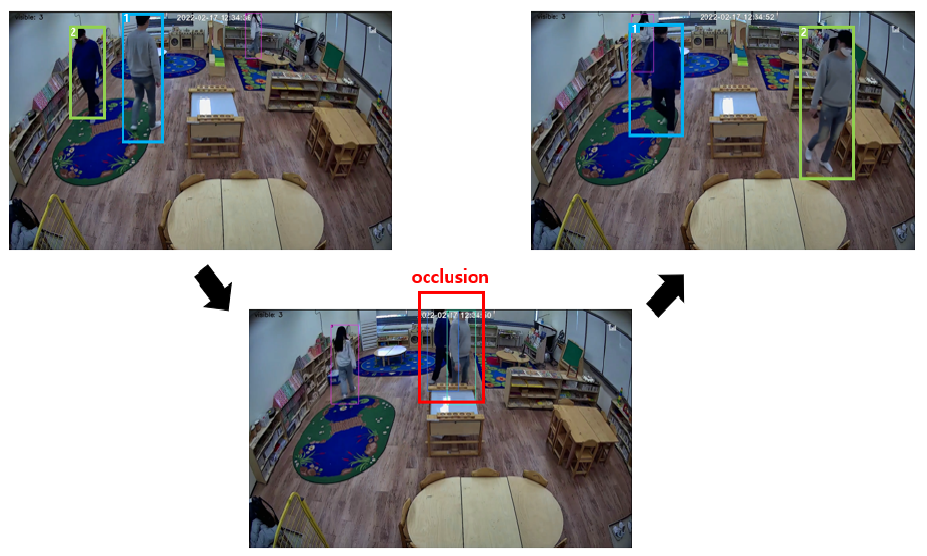
Figure 5. ID switching owing to short-term occlusion.